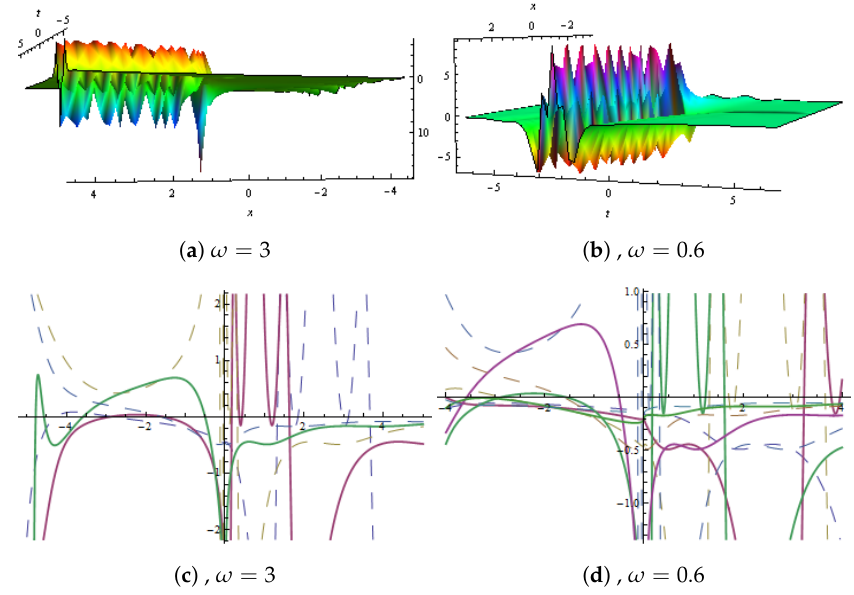
Figure 5. ( a , b ) show 3D plots and ( c , d ) show two-dimensional